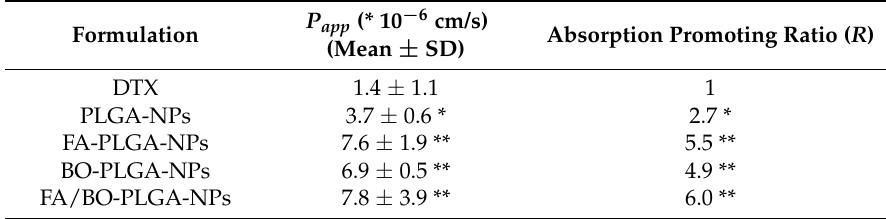
Figure 4. Small intestinal absorption in vitro: cumulative amount of DTX in 2 h. * p < 0.05, ** p < 0.01. Table 1. Small intestinal absorption in vitro: apparent permeability coefficient ( P app ) and absorption promoting rate ( R ).